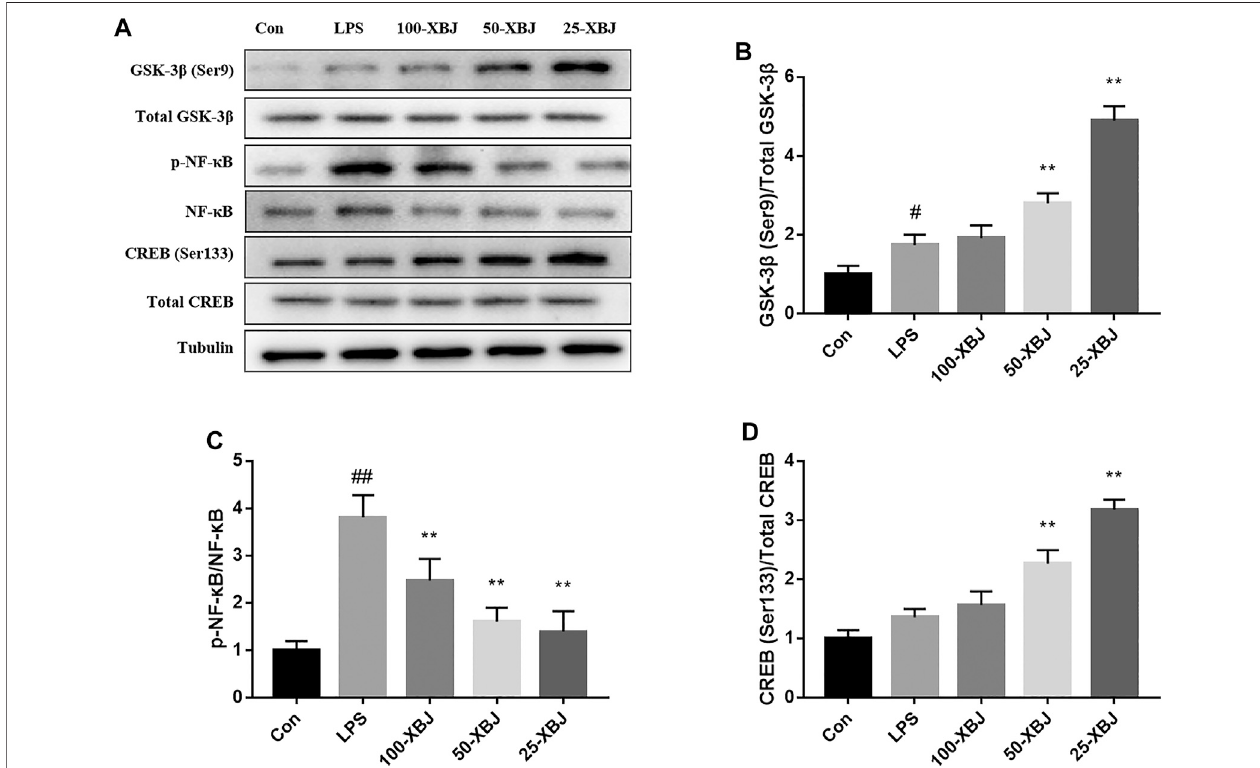
FIGURE 7 | XBJ regulates the activities of GSK-3 β , NF- κ B and CREB in LPS-induced ALI cells (A) Representative immunoblots of GSK-3 β , NF- κ B and CREB proteinexpressionincelllysates. (B-D) AdministrationofXBJincreasedGSK-3 β andCREBactivity,whileNF- κ Bactivitywasreduced invitro. Con:controlgroupwithout LPS treatment; LPS: model group with LPS treatment; 100-XBJ: group with LPS treatment + XBJ injection diluted 100 times; 50-XBJ: group with LPS treatment + XBJ injection diluted 50 times; 25-XBJ: group with LPS treatment + XBJ injection diluted 25 times. Compared with the control group, # p < 0.05, ## p < 0.01 were considered to be signi fi cant; Compared with the CLP group, * p < 0.05, ** p < 0.01 were considered to be signi fi cant. Data are expressed as mean ±